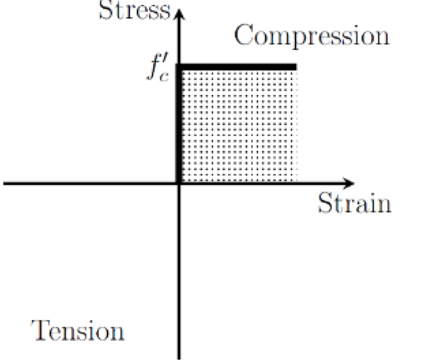
Figure 1. Constitutive law of concrete.